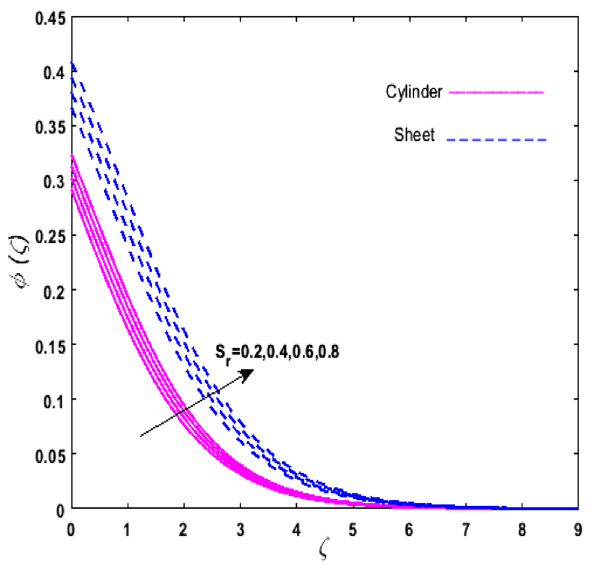
Figure 15. Upshot of S r on φ(ζ)